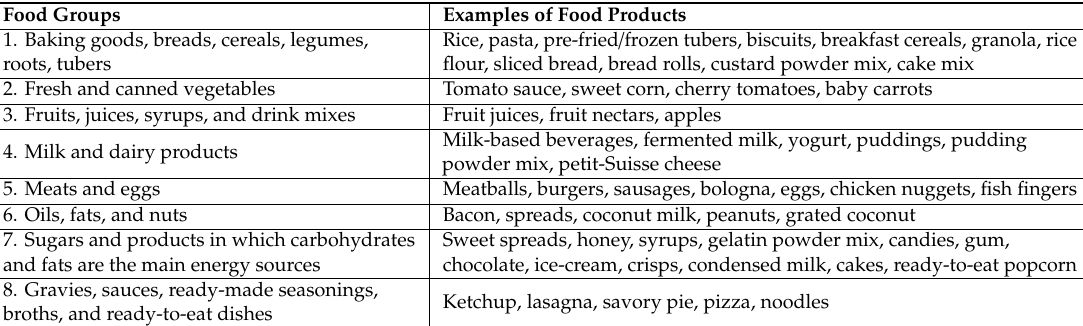
Table 2. Examples of food products available in the supermarket, classified in the eight groups established by Brazilian and Mercosur